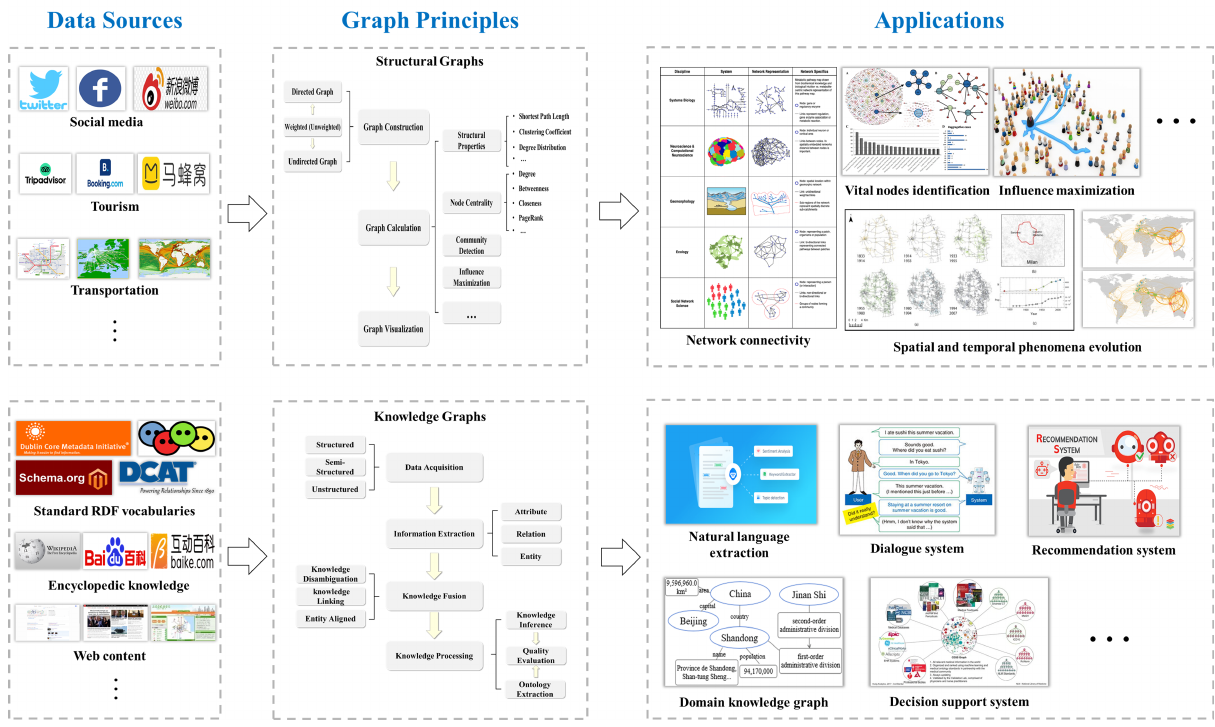
Figure 1. ST-graph vs. K-graph